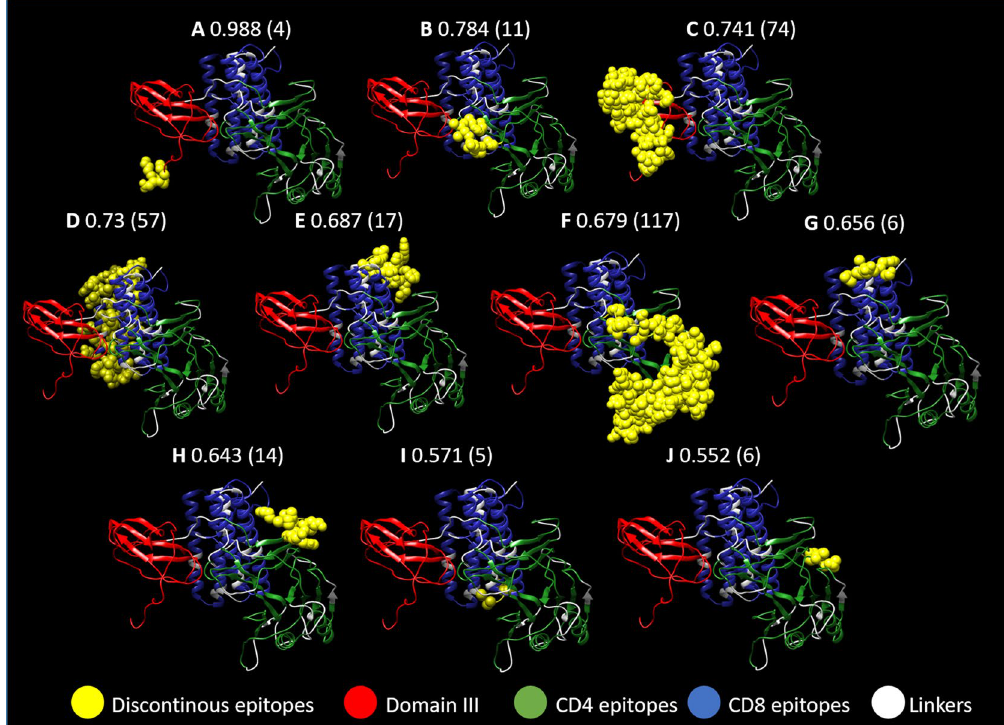
Figure 6. Discontinuous epitopes present in the vaccine construct. Two epitopes are located at the Envelope Domain III portion of the protein ( A and C ) with some of the highest scores (0.988 and 0.741) and with 4 and 74 amino acids, respectively. The other discontinuous epitopes are distributed among the CD4 and CD8 epitopes ( B , D – J ). In yellow are the predicted discontinuous epitopes, in red the domain III from the ZIKV Envelope protein, in green CD4 epitopes, in blue CD8 epitopes and in white the linkers.